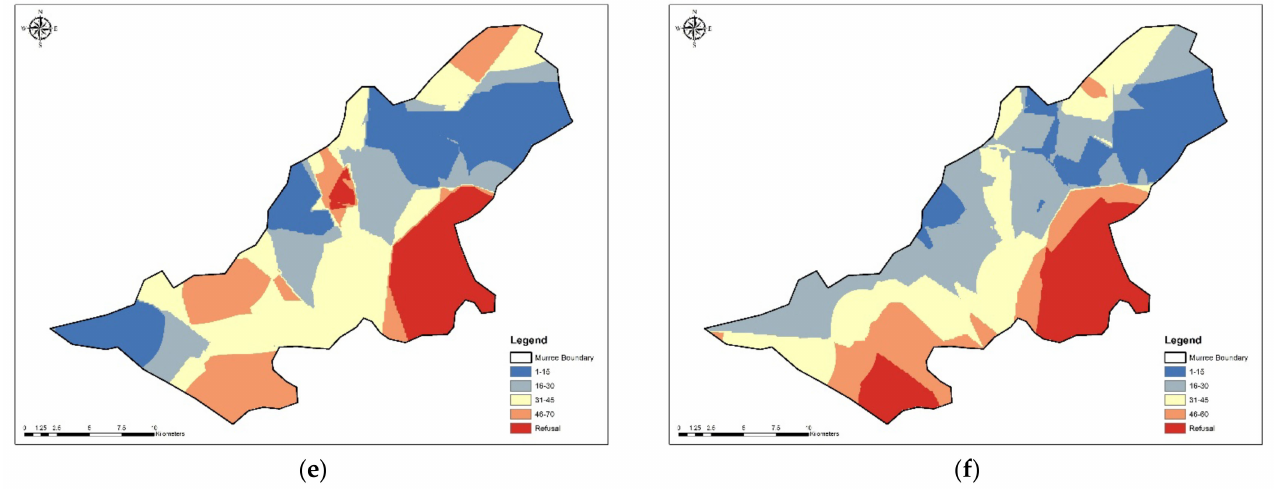
Figure 4. SPT N maps at ( a ) 1.52 m depth, ( b ) 3.05 m depth, ( c ) 4.57 m depth, ( d ) 6.10 m depth,